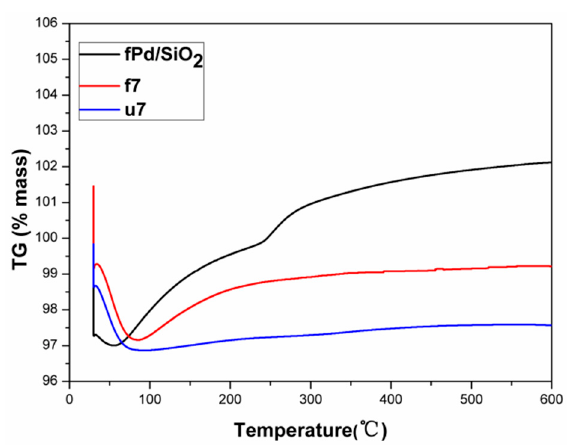
Figure 8. Temperature-programmed Oxidation (TPO) profiles of the (u7, f7) catalyst and freshly prepared Pd / SiO 2